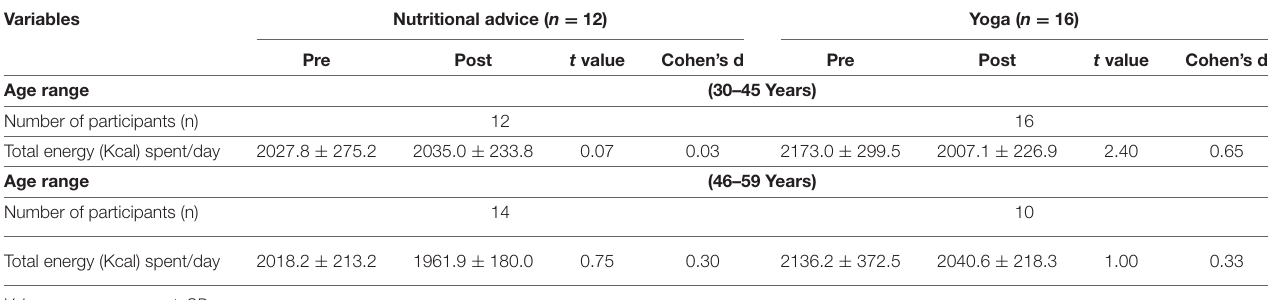
TABLE 11 | Estimated energy expenditure/day based on (i) International Physical Activity Questionnaire—Short Form and (ii) Harris-Benedict equation to determine the basal metabolic rate for two different age range i.e., 30-45 and 46-59 years. Variables Nutritional advice ( n = 12)